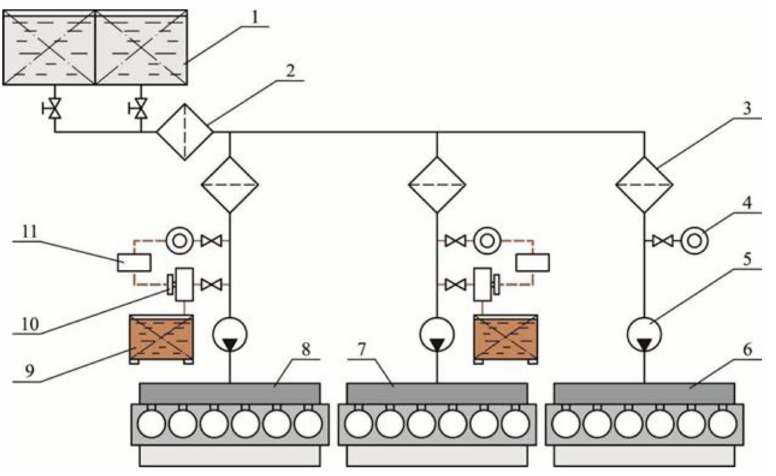
Figure 2. Fragment of the fuel feed system of marine diesel engines 6N165LW Yanmar: 1—service tank of diesel fuel RMA10; 2—first-stage fuel filter; 3—second-stage fuel filter; 4—flow meter; 5—fuel pump; 6, 7, and 8—auxiliary diesel 6N165LW; 9—service tank biodiesel fuel FAME; 10—dispenser;